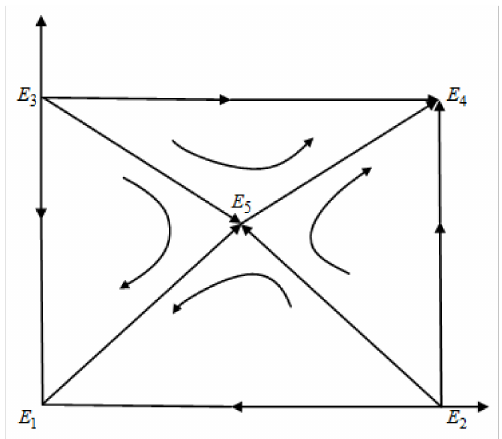
Figure 2. Evolution steady-state